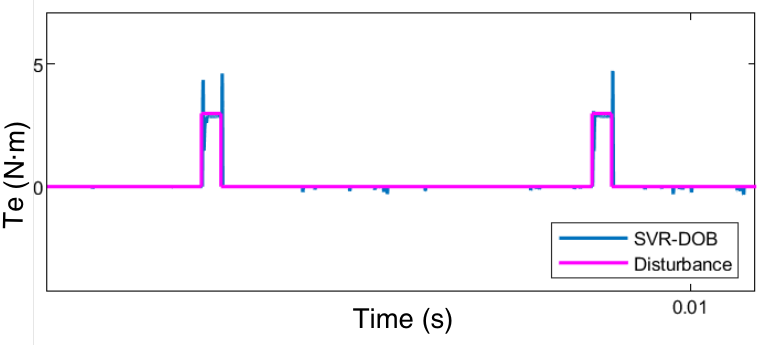
Figure 6. Disturbance estimation of